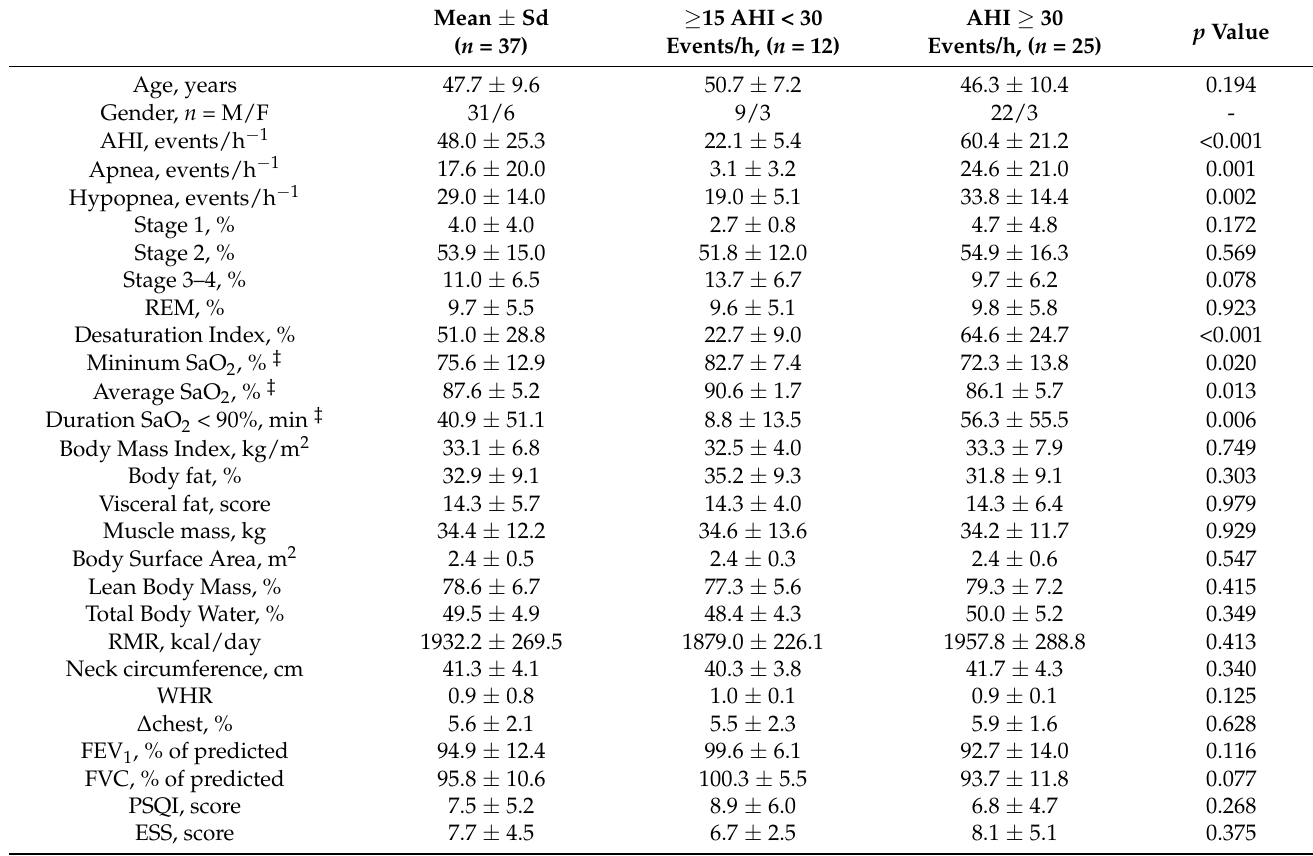
Table 1. Patients characteristics. Data are expressed as mean ± standard deviation.